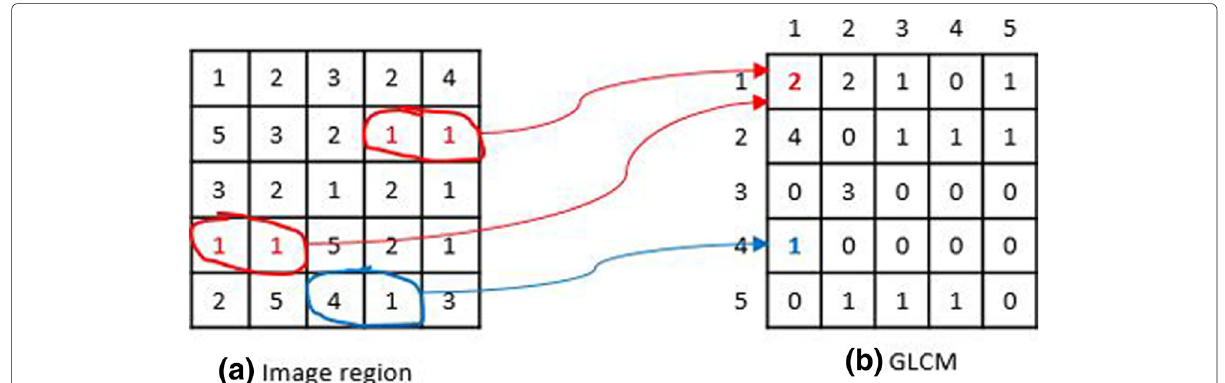
Fig. 14 a , b GLCM calculation with d = 1, θ = 0 o . The figure shows how GLCM at angle 0 is calculated. The figure is supplied as